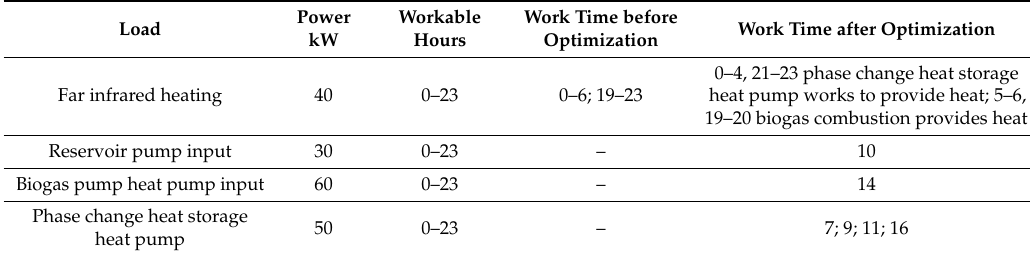
Figure 8. The stored energy curve of energy stores on a winter rainy day. Table 3. Energy storage working time before and after optimization on a rainy winter